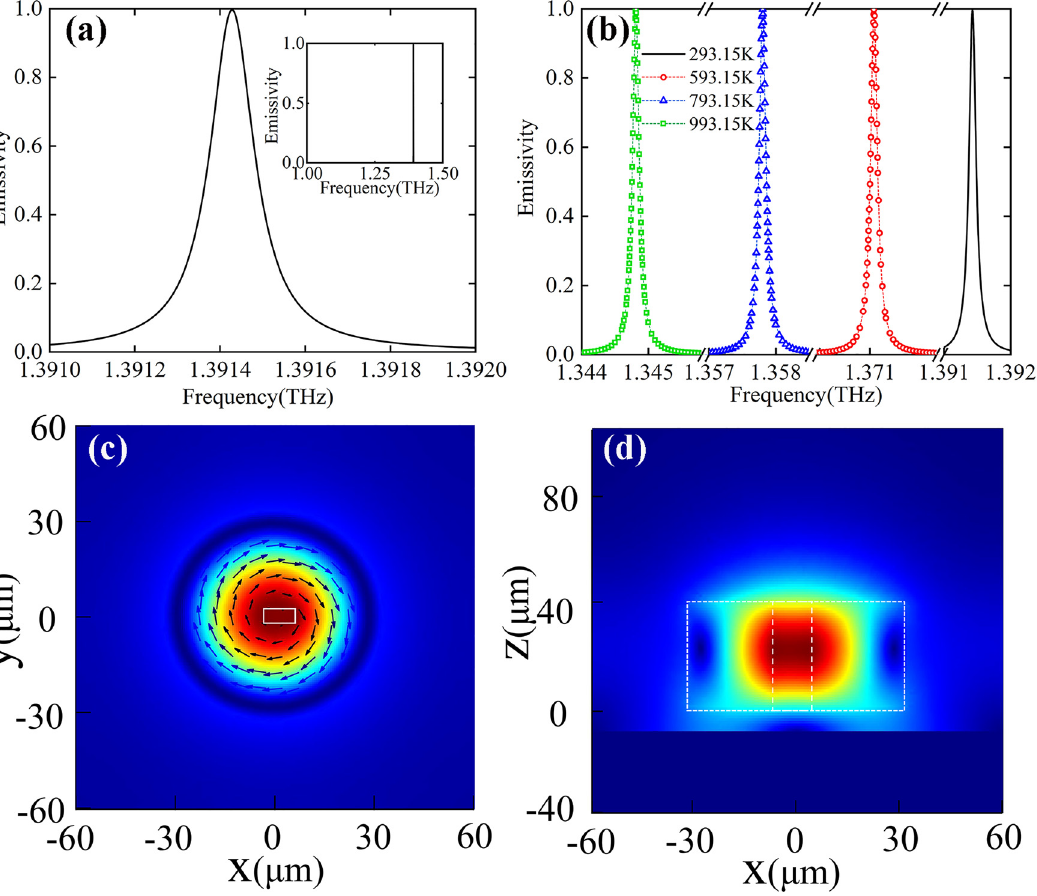
Figure 3: (a) Normalized emission spectrum of the slotted Si disk array at normal direction and y -polarization; the inset shows the narrow spectral response of the device in a broader bandwidth scale (1.0 – 1.5 THz); (b) emission spectra at different temperatures by fully taking into accountthethermalin fl uencetothepropertiesofHRSi.Theredcircle,bluetrianglesandgreensquaresrepresentstheemissivitycalculatedat 593.15, 793.15, and 993.15 K; (c) top view of the magnetic fi eld and electric fi eld vectorial distribution at resonance across the central plane of the Si disk array. (d) The xz cross-sectional view of the magnetic fi eld amplitude distribution at